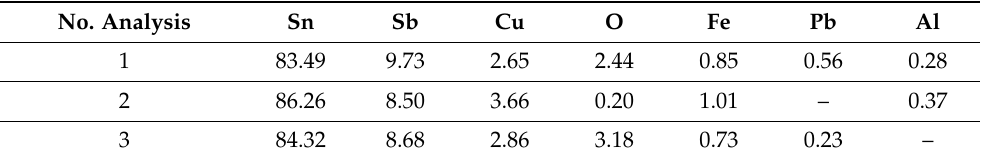
Table 5. EDX analysis of selected zones from Figure 4a of the wear surface of B83 babbitt at a load of 40 N, mass norm., %.